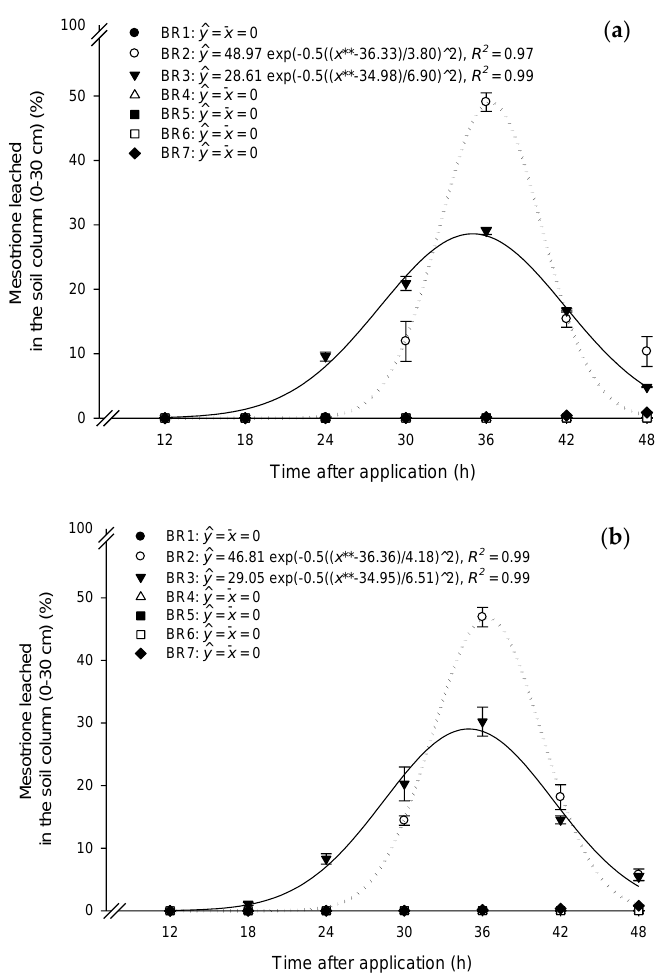
Figure 2. Percentage of leached 14 C-mesotrione applied alone ( a ) and in mixture with S-metolachlor plus terbuthylazine ( b ) in glass columns (0–30 cm) packed with tropical soils, represented by BR1, BR2, BR3, BR4, BR5, BR6 and BR7 with simulation 200 mm of water and collected at 12, 18, 24, 30, 36, 42 and 48 h after application. The vertical bars associated with each column represent the standard deviation (±SD) of each mean value ( n = 3). ** p < 0.01 by the F test.